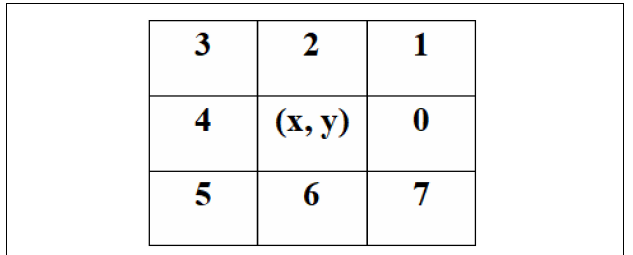
FIGURE 11 | Pixel eight neighborhoods graph.